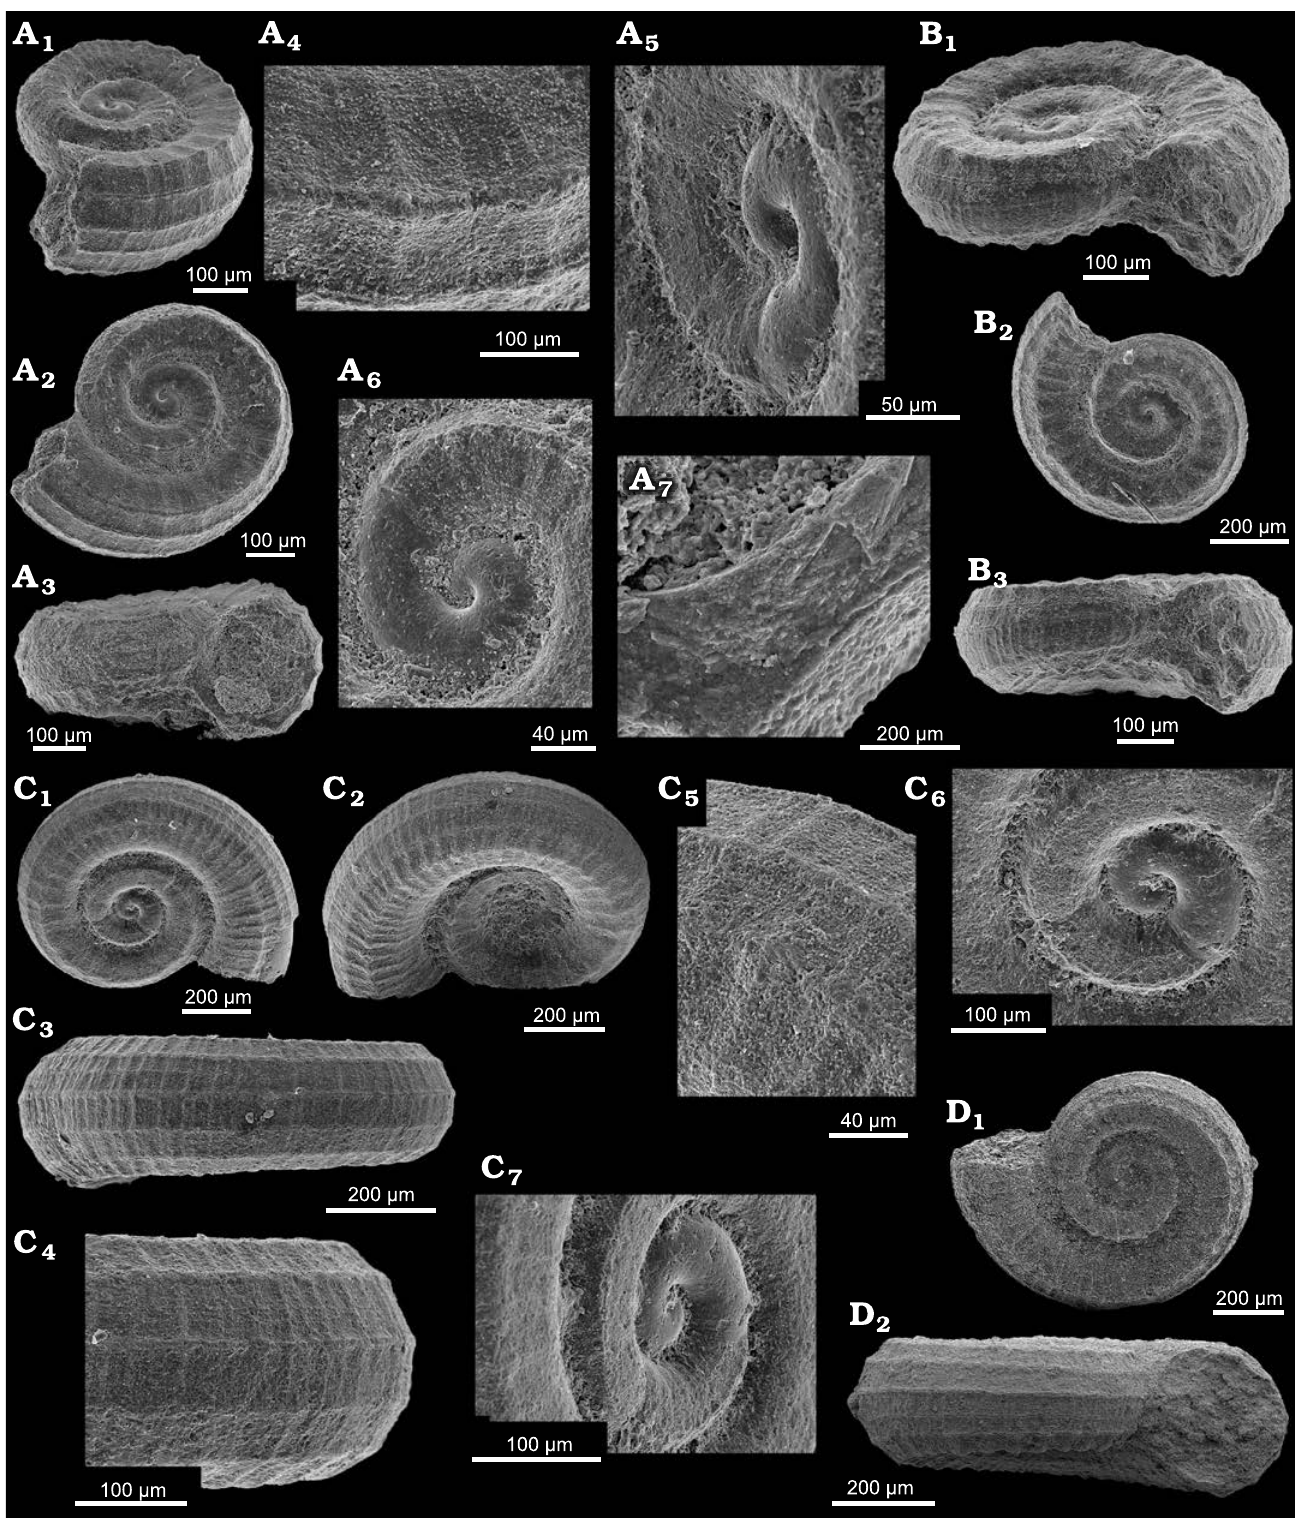
Fig. 24. Stuoraxid gastropod Ampezzogyra angulata Nützel and Hausmann sp. nov. from Lago Antorno (A, C) and Misurina Landslide (B, D), Cassian Formation, northern Italy, Late Triassic. A . Paratype PZO 12848, in oblique lateral (A 1 ), apical (A 2 ), and apertural (A 3 ) views; A 4 , detail teleoconch at adapical whorl angulation with micro-ornament of fine tubercles; A 5 , protoconch in oblique lateral view; A 6 , protoconch in apical view; A 7 , crossed lamel- lar shell structure. B . Paratype PZO 12733, in oblique lateral (B 1 ), apical (B 2 ), and apertural (B 3 ) views. C . Holotype PZO 12847, in apical (C 1 ), basal (C 2 ), and apertural (C 3 ) views; C 4 , detail of C 3 ; C 5 , detail teleoconch with micro-ornament of fine tubercles; C 6 , protoconch in apical view; C 7 , protoconch in oblique view. D . Paratype PZO 12734, in apical (D 1 ) and apertural (D 2 )